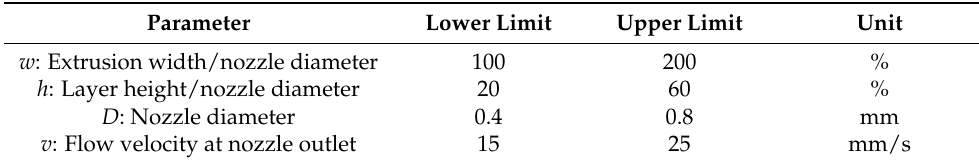
Table 1. Investigated parameters, their limits and